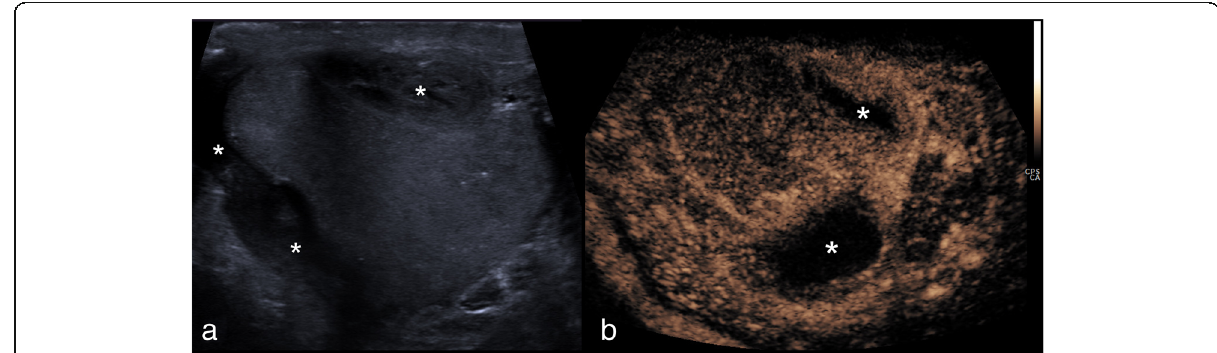
Fig. 8 CEUS appearances of extra-testicular haematoma. On B-mode ( a ), a note is made of an extratesticular hypoechoic haematoma (asterisks) causing compression of the testicular parenchyma. Essential issues in such cases include the thorough assessment of testicular parenchymal perfusion and integrity of the adjacent tunica, to rule our testicular rupture. CEUS ( b ) showed uniform enhancement of the testis and excludes focal ischaemia secondary to extrinsic compression, confirming that the tunica albuginea is intact. The extratesticular haematomas shows no internal enhancement (asterisks) but a rim of perilesional